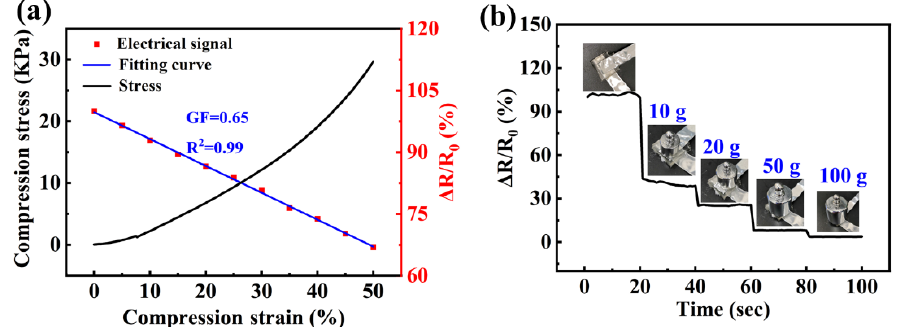
Figure 5. ( a ) Compression stress and compression strain and ( b ) Resistance changes of hydrogel response to different weights.